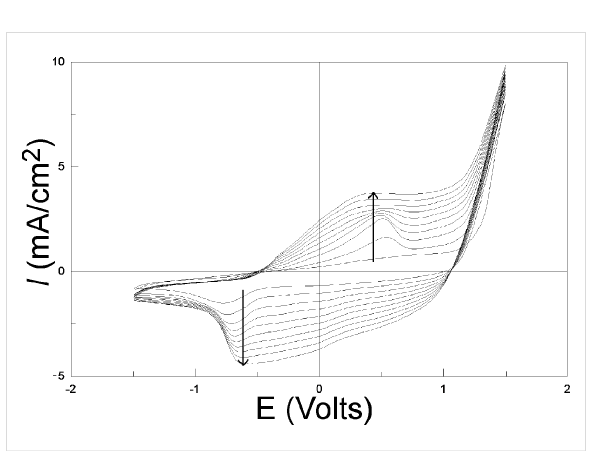
Figure 5: 10 successive CVs performed on vitreous carbon with 10 mM EDOT and 0.1 M LiClO 4 in acetonitrile solution. Scan rate: 100 mV/s. The arrow direction indicates increasing scan